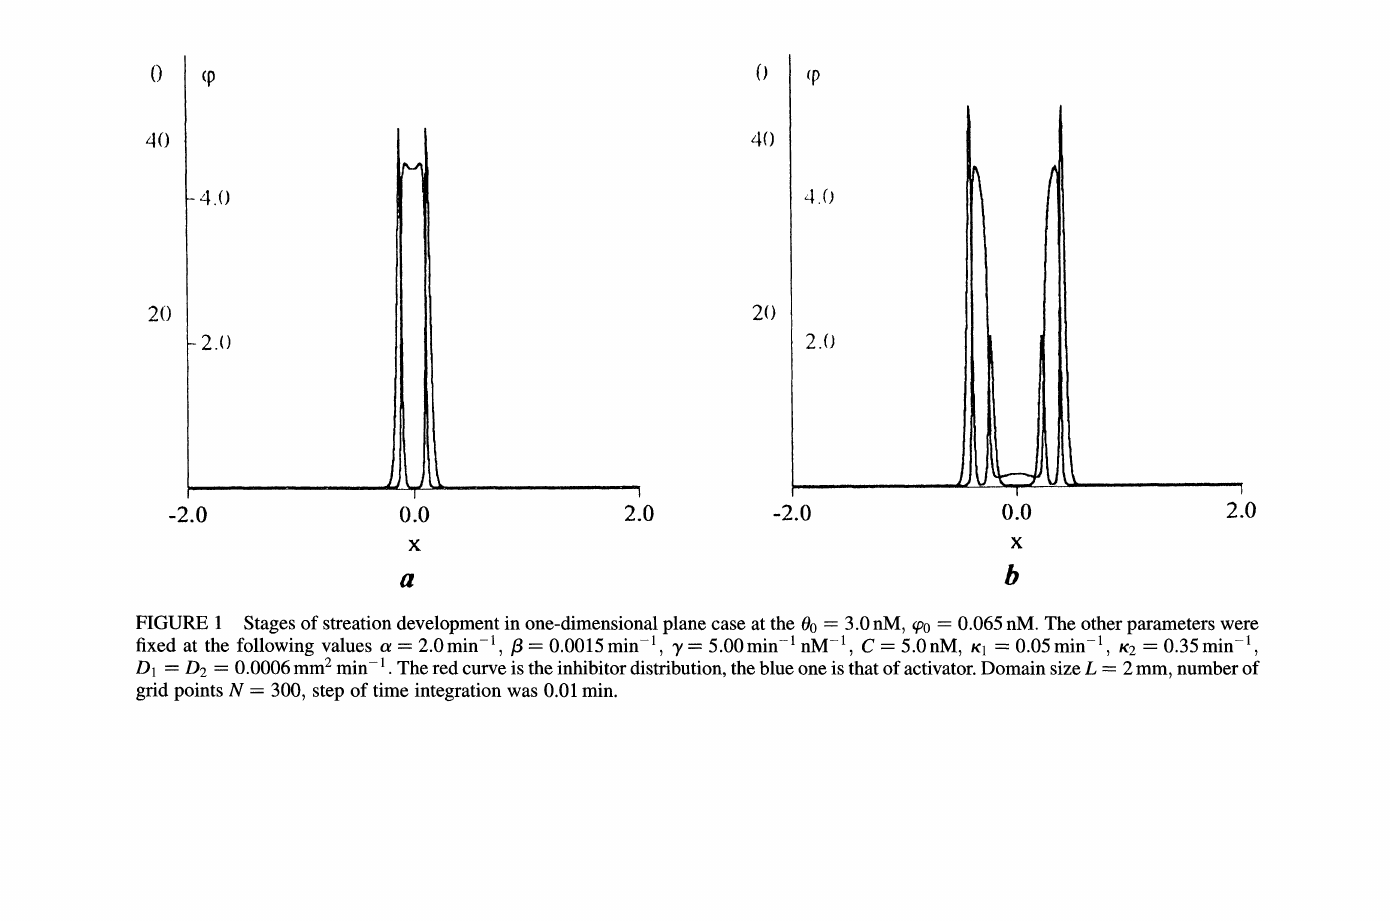
Stages of streation development in one-dimensional plane case at the 00 3.0 nM, q0 0.065 nM. The other parameters were fixed at the following values a 2.0min -1, /3 0.0015 min -1, y= 5.00min -1 nM -1, C 5.0nM, K1 0.05 min -1, K2 0.35 min D D2 0.0006 mm min- 1. The red curve is the inhibitor distribution, the blue one is that of activator. Domain size L 2 mm, number of grid points N 300, step of time integration was 0.01